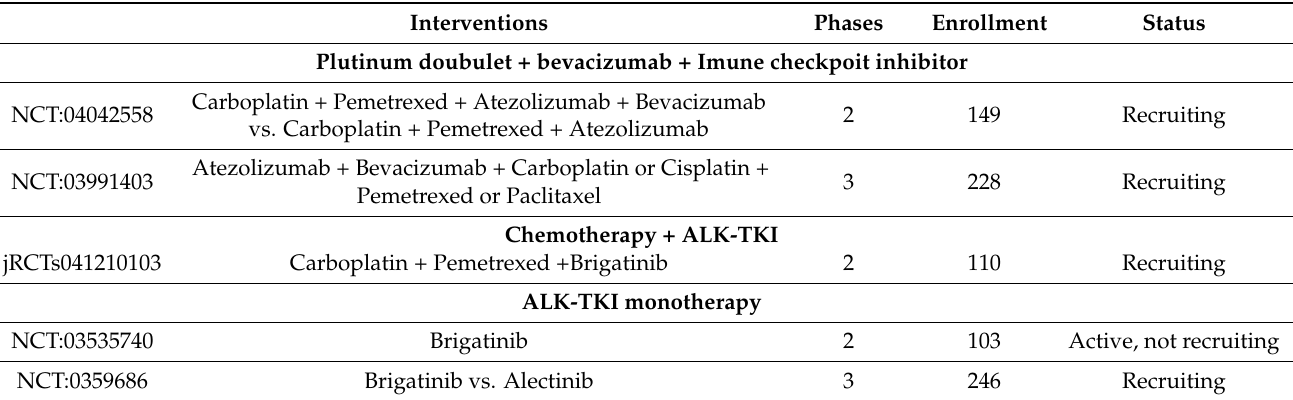
Table 7. Cont. Interventions